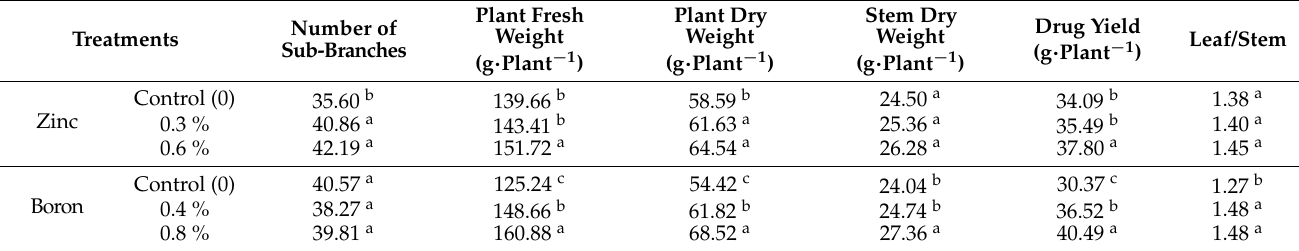
Table 2. Mean comparison of the simple effects of boron and zinc foliar application on biomass and yield attributes of S. khuzistanica in the first year of the experiment. Treatments